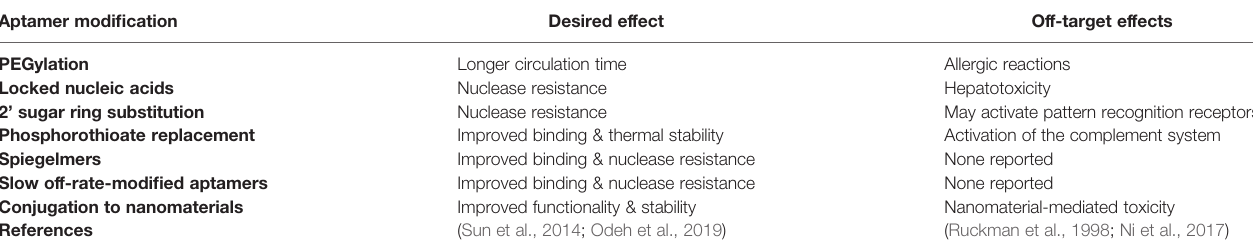
TABLE 2 | Common chemical modi fi cations for improvement of aptamer performance in pharmacological studies. Aptamer modi fi